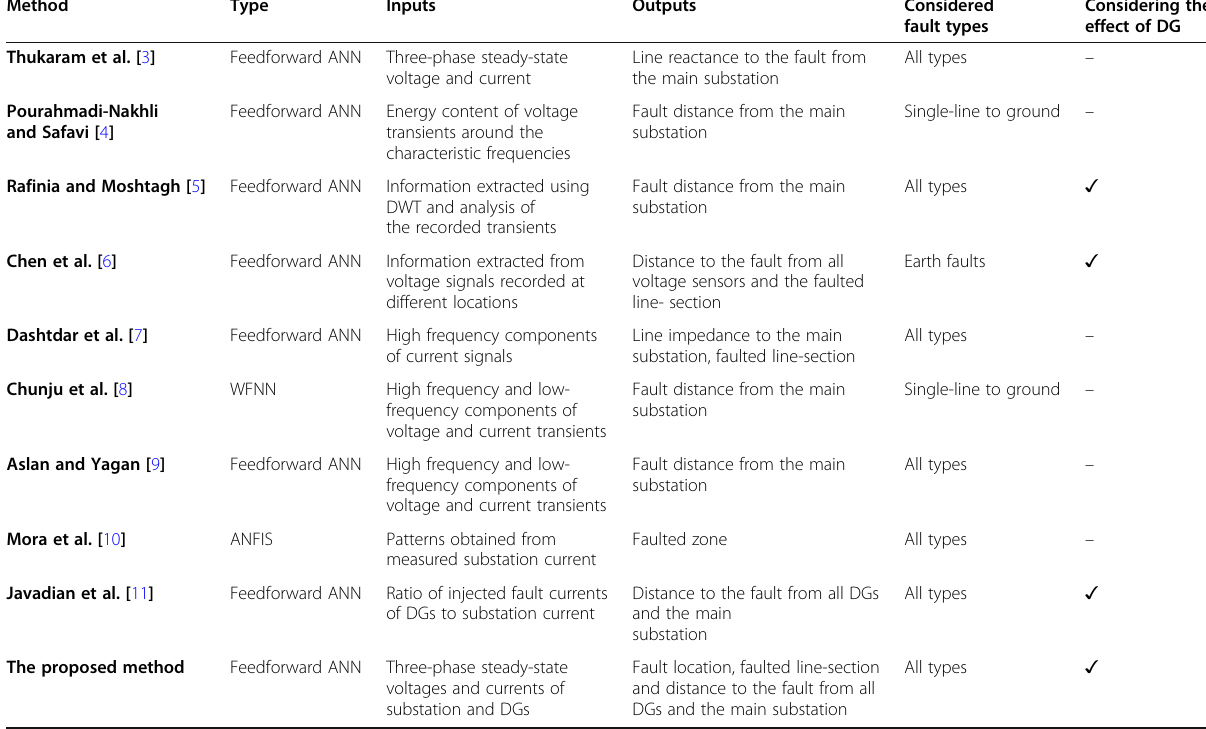
Table 1 Comparison of the ANN-based fault location methods